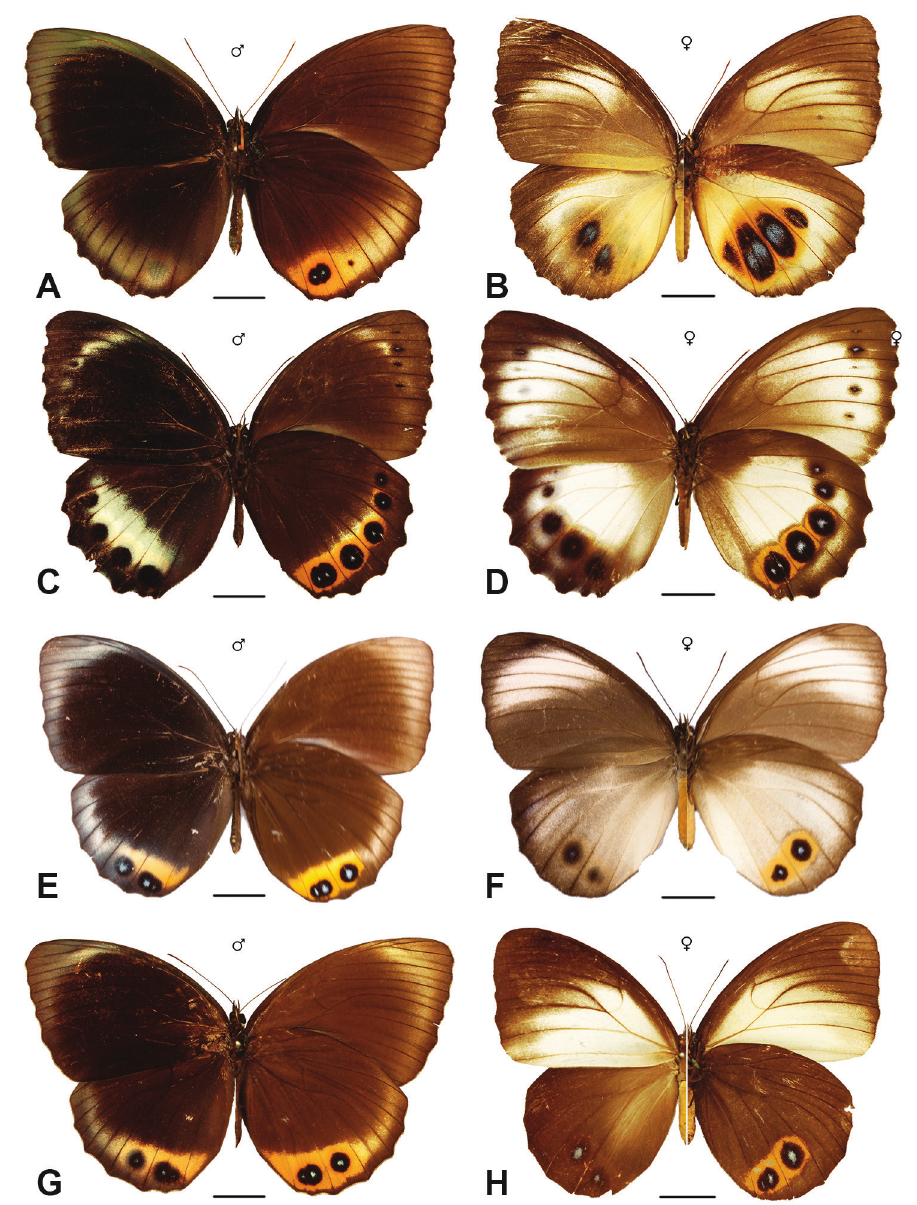
Figure 16. A agondas agondas ♂ D+V NHM Indonesia: West Papua B agondas agondas ♀ D+V NHM Indonesia: West Papua C agondas melane ♂ D+V NHM Indonesia: Maluku, Kei Island D agondas melane ♀ D+V NHM Indonesia: Maluku, Kei Island E agondas glaucopis ♂ D+V NHM Papua New Guinea: Oro Province, Kumusi River F agondas glaucopis ♀ D+V NHM Papua New Guinea: Oro Prov- ince, Kumusi River G agondas melanippe ♂ D+V NHM Papua New Guinea: Morobe Province, Huon Peninsula, Sattelberg H agondas melanippe ♀ D+V NHM Papua New Guinea: Morobe Province, Huon Peninsula,